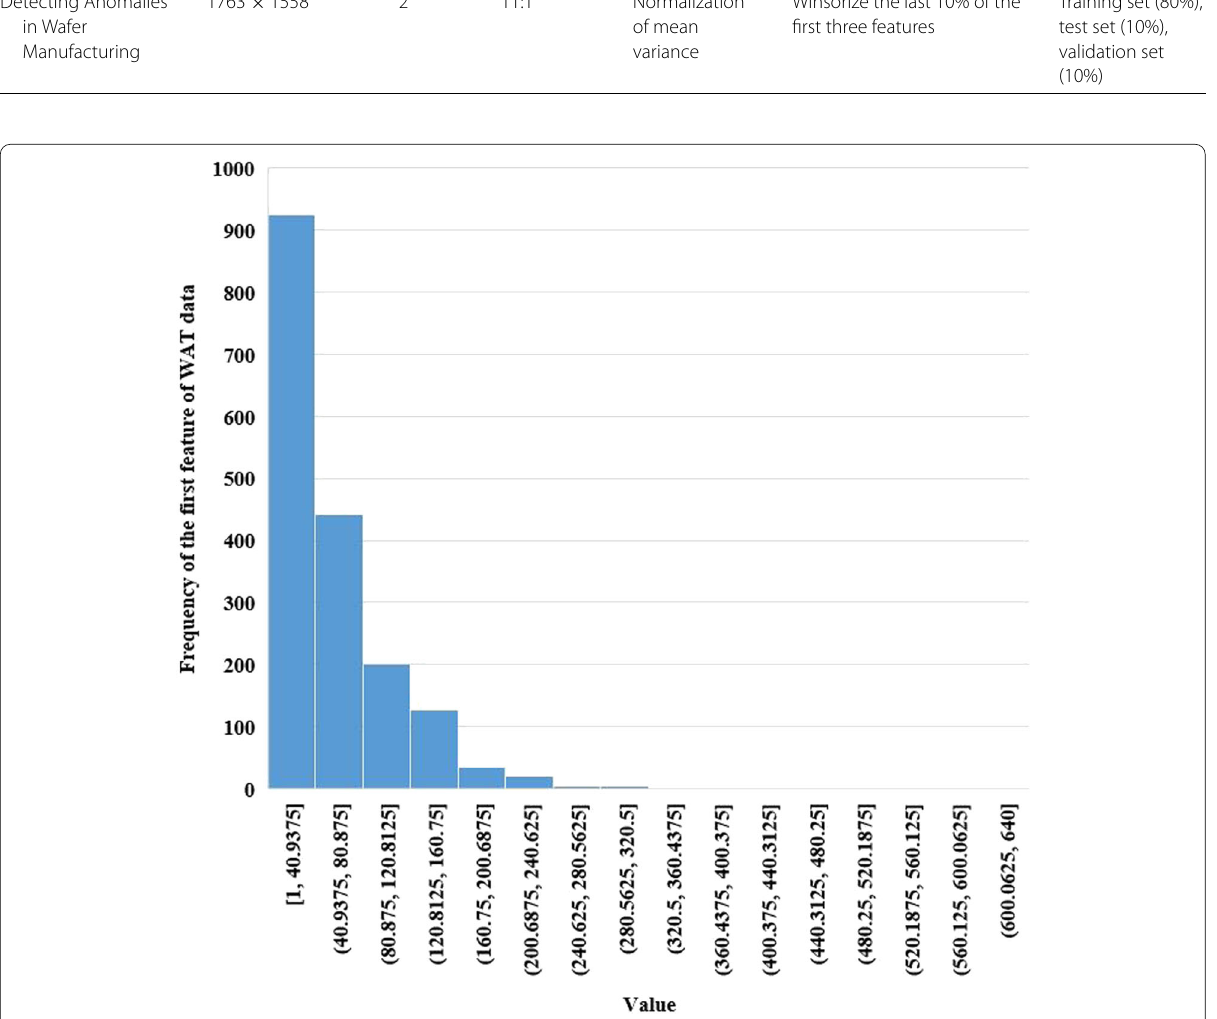
Figure 3 First original feature data distribution of WAT